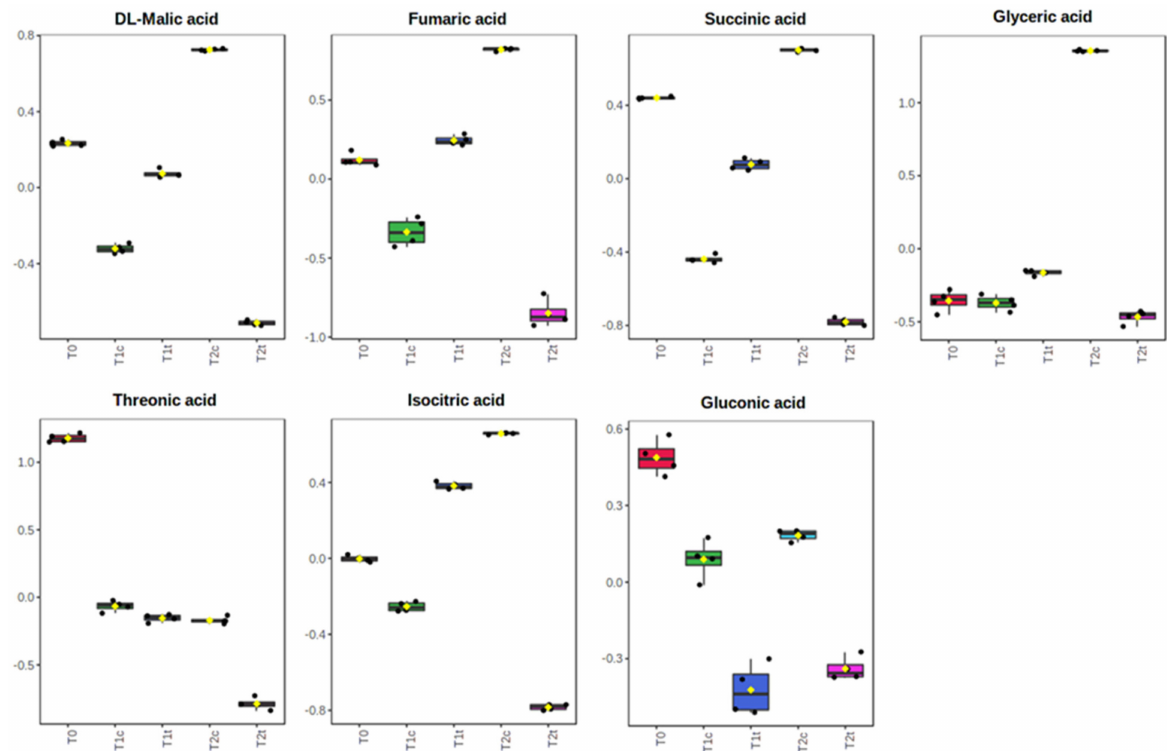
Figure 6. Effects of 0 h, 24 h, and 48 h of coumarin treatment (400 µ M) on the contents in R. sativus seeds from the organic acids pool. Normalised metabolomic data were analysed through ANOVA using the LSD test as post hoc ( p ≤ 0.05). N = 4. For the full list of the significantly altered metabolites, refer to Supplementary Table